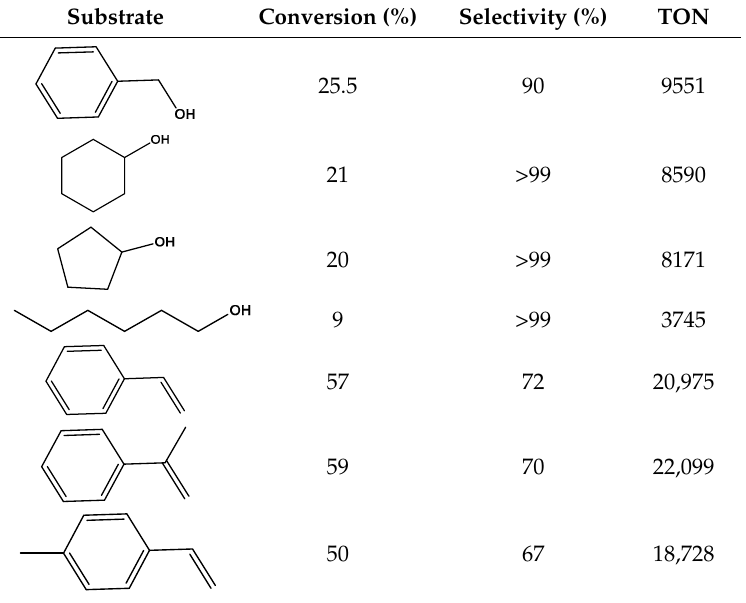
Table 4. Catalytic oxidation of various substrates by oxygen catalyzed with PMo 11 /H β [78] a .